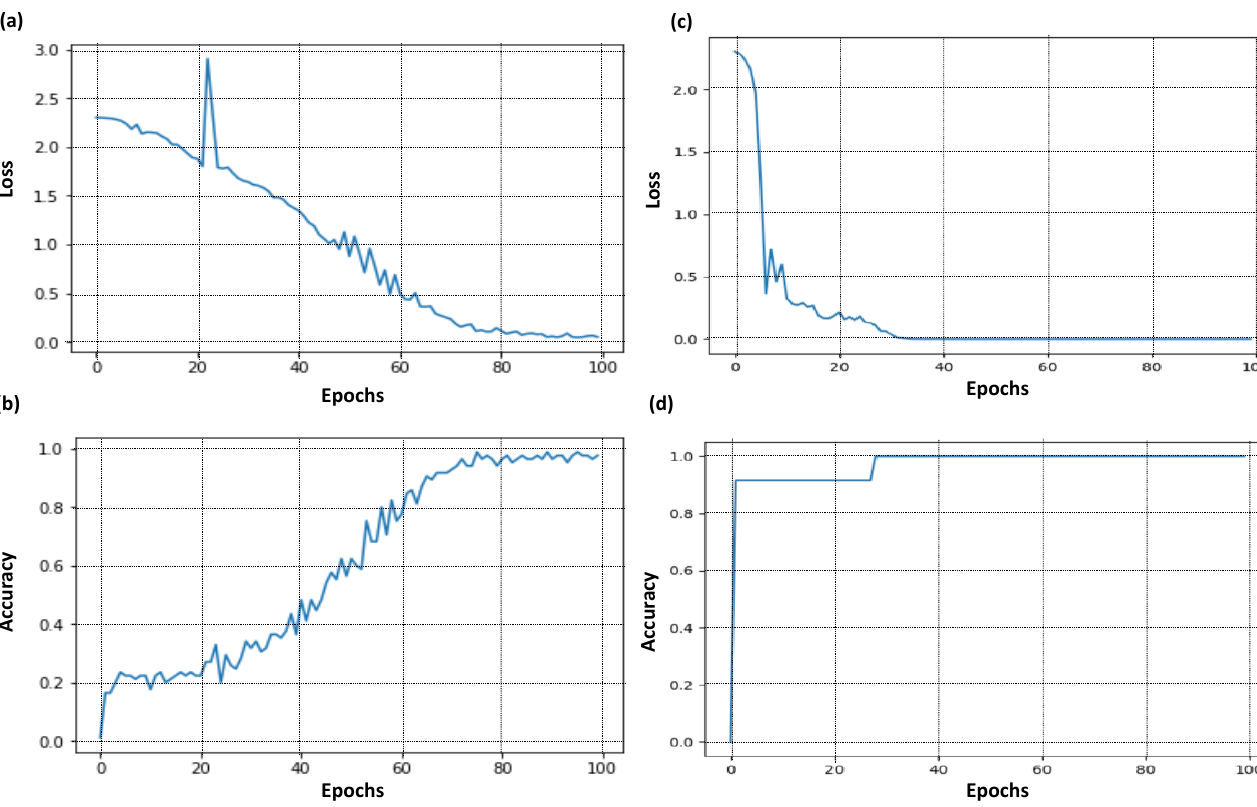
Figure 7. LSTM performance of the training phase (the training dataset is the 95% of the whole dataset): ( a ) Loss trend versus epoch number. ( b ) Accuracy trend versus epoch number. LSTM performance of the testing phase: ( c ) Loss trend versus epoch number. ( d ) Accuracy trend versus epoch number.